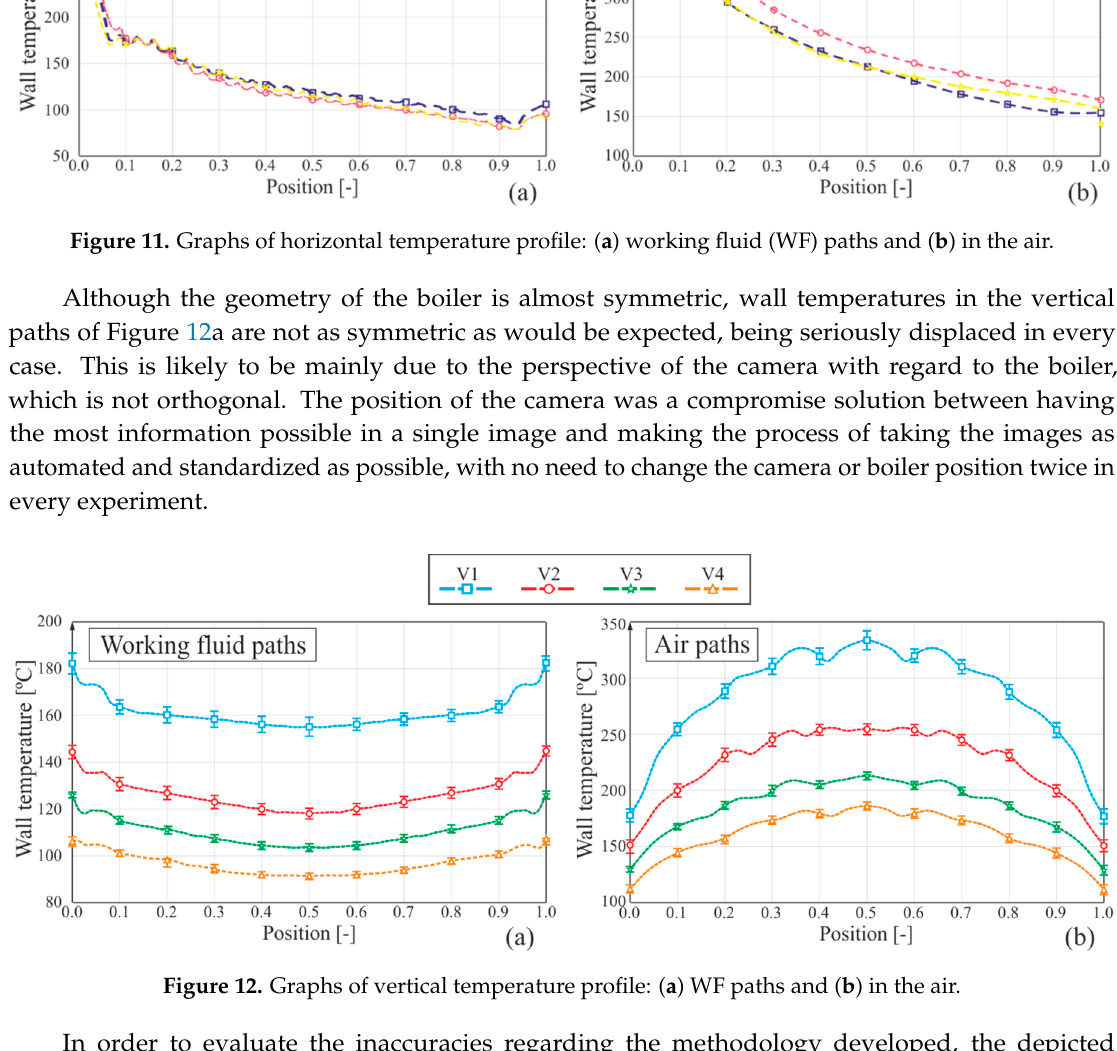
( b ) Figure 13. Comparison of temperature measurements following the methodology, in the same line, at two different moments. Analysis of a vertical line ( a ), and a horizontal line ( b ). 5. Conclusions In this study, an experimental bench was presented to test boilers for an Organic Rankine Cycle in a waste heat recovery system, as well as a methodology to detect and analyze them via pattern recognition with thermography. This methodology is able to handle a large number of thermal images in a database and automatically extract paths of wall temperatures. These paths could be